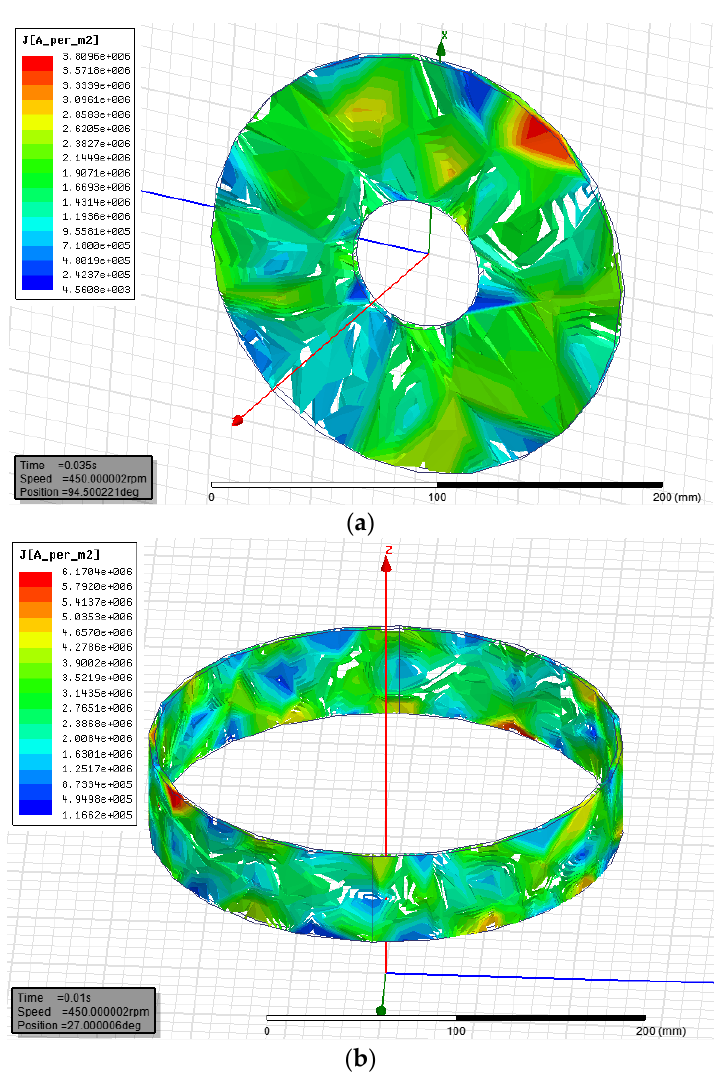
Figure 6. Eddy current loss of copper conductor: ( a ) axial; ( b ) radial.